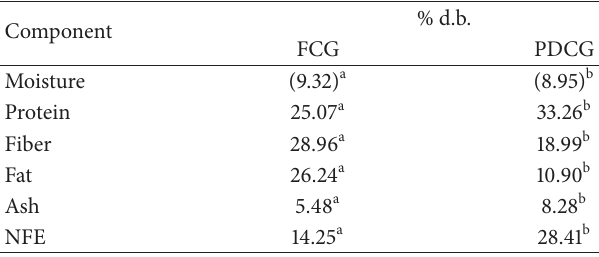
Table 1: Proximal composition of fatted and partly defatted chia